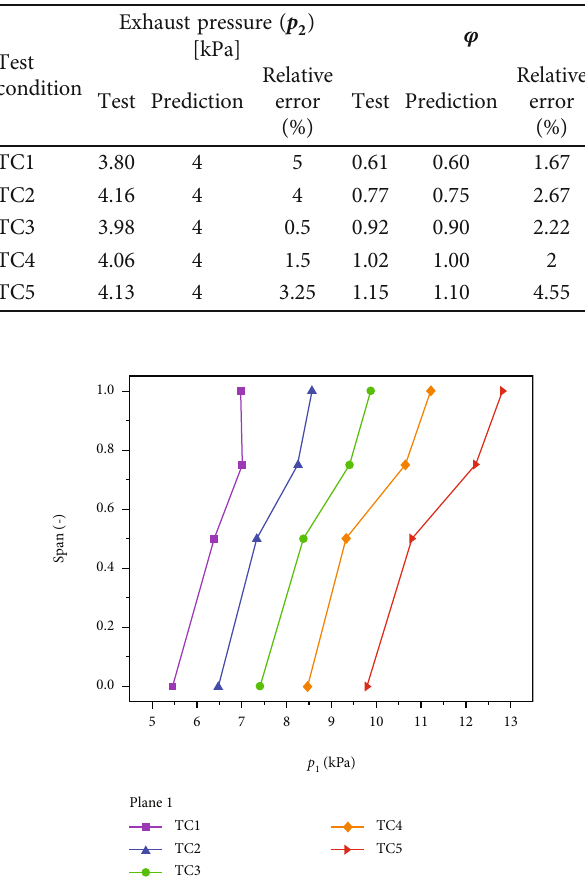
Figure 4: Static pressure distribution in plane 1 for di ff erent φ .